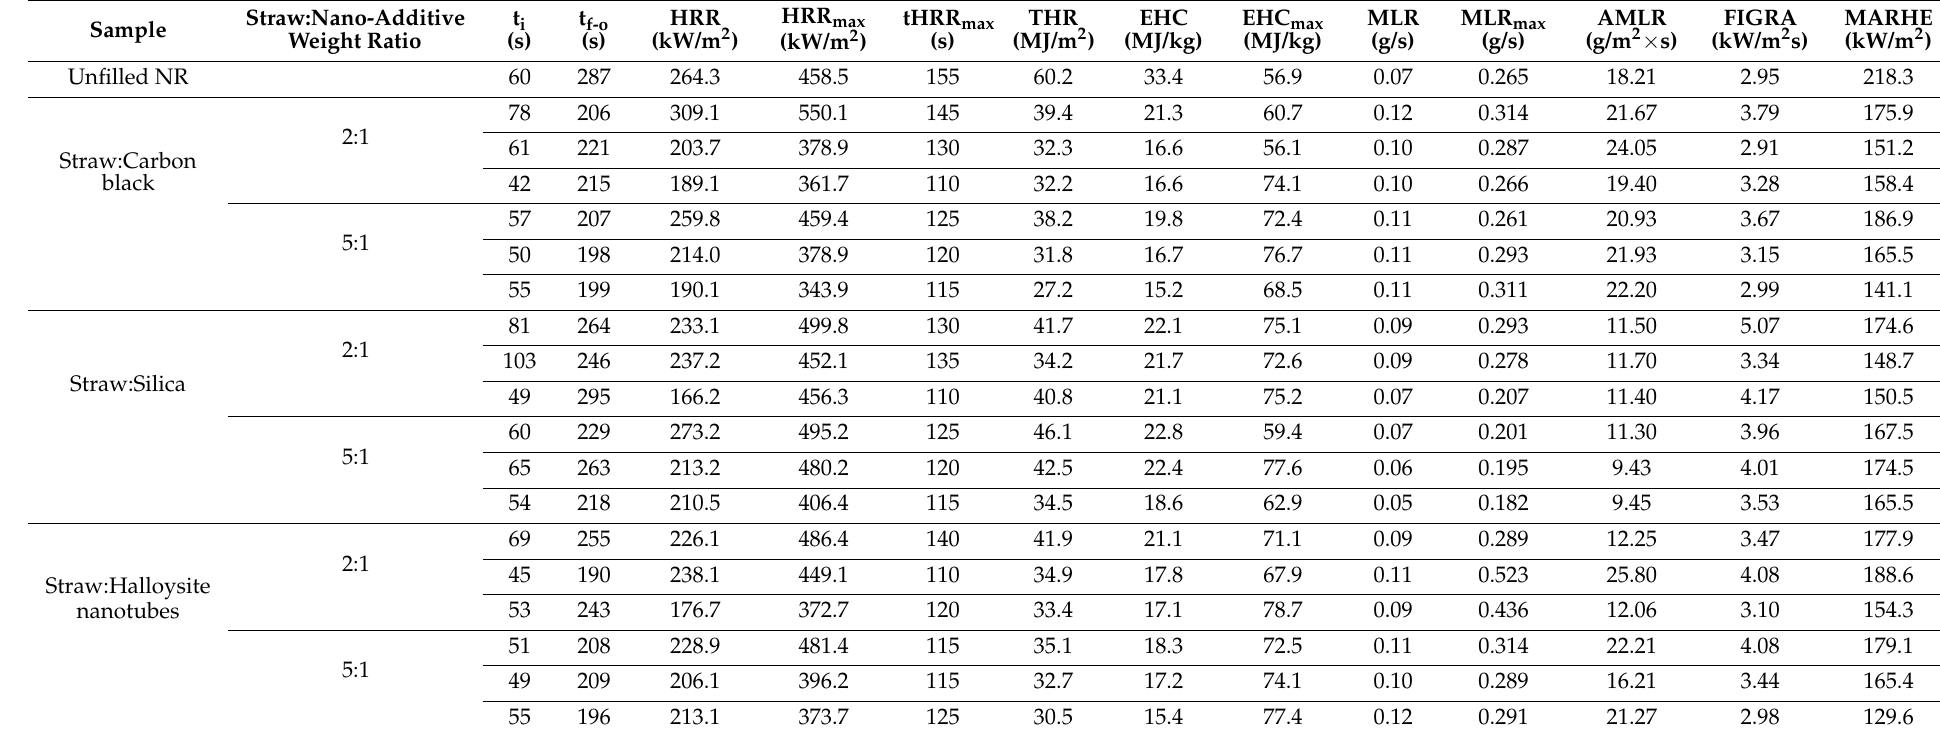
Table 7. Flammability results of vulcanizates analyzed on a cone